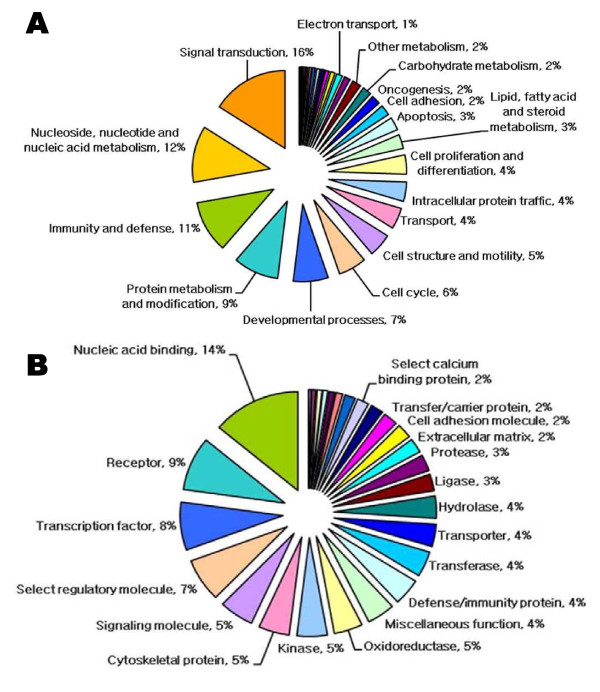
Functional categorization of the genes showing significant transcriptional differences in the transgenic and control mice. A total of 2,672 genes were categorized on the basis of Gene Ontology (GO) annotation, and the proportion of each category is displayed on the basis of biological process (A) and molecular function (B).